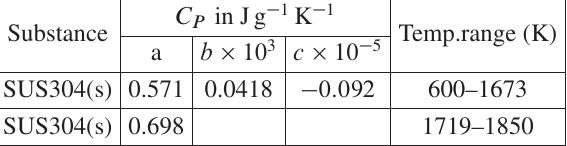
Table 4. Table 4 Heat capacity of the SUS304 stainless